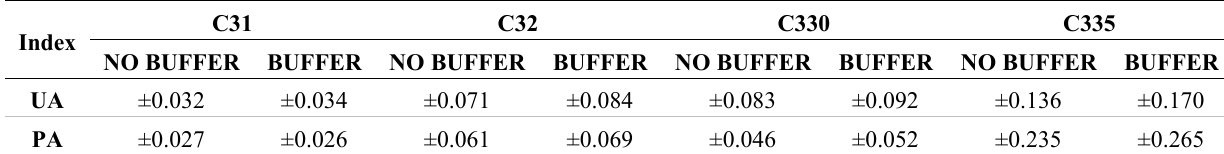
Table 7. Comparison between GlobeLand30 2000 and DUSAF1.1 (II reclassification): per-classes confidence intervals at 95% probability calculated for user (UA) and producer accuracies (PA). Data refer to 30 m resolution input datasets.